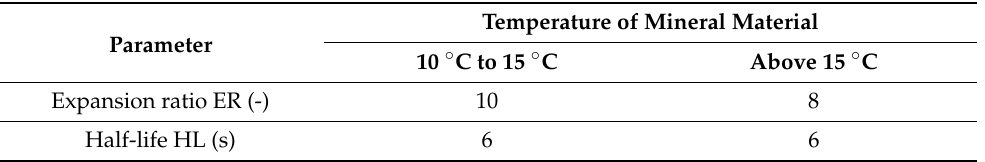
Table 11. Minimum values of foamed bitumen parameters for CMA [59].